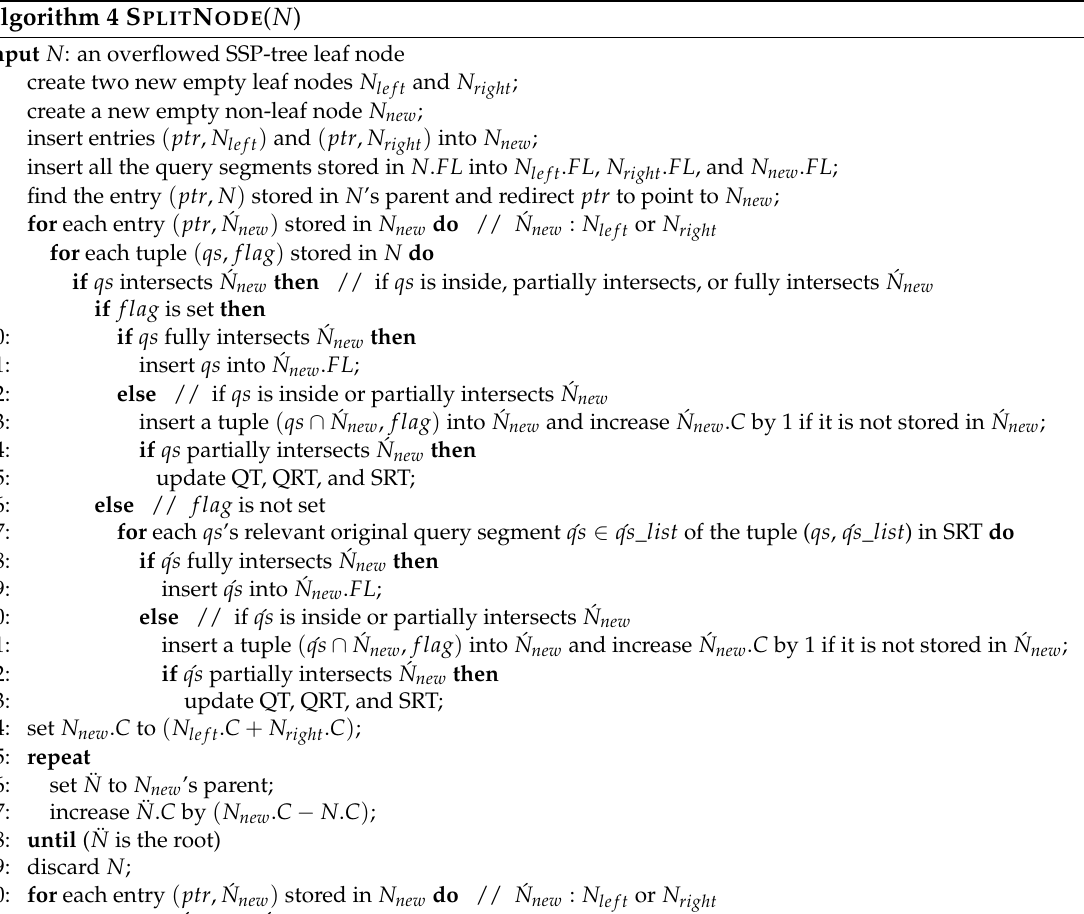
Algorithm 5 is the pseudocode of the delete algorithm D ELETE . Given an original query